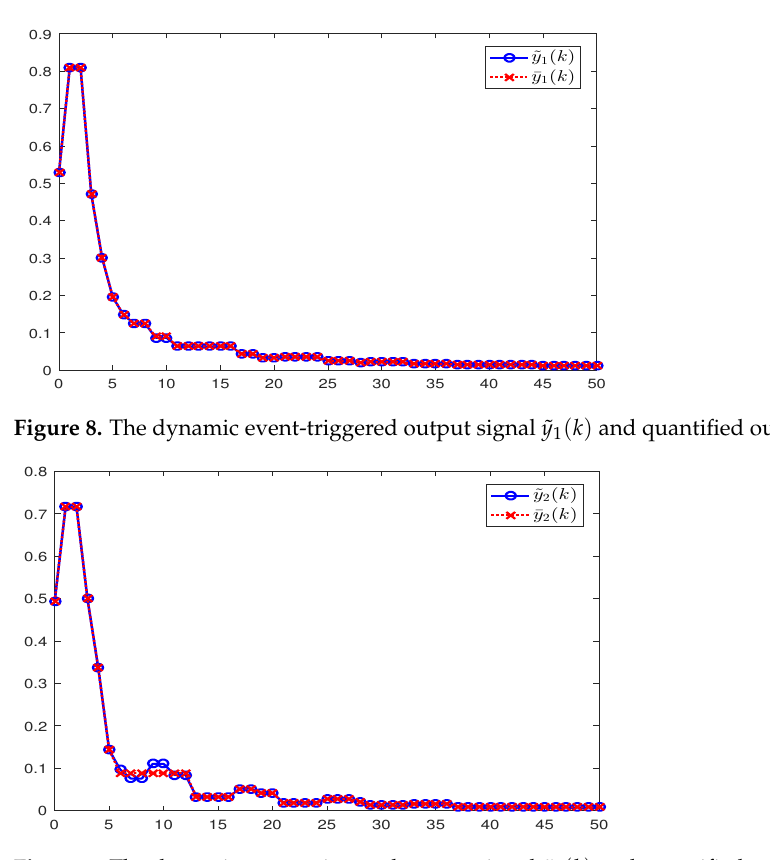
Figure 9. The dynamic event-triggered output signal ˜ y 2 ( k ) and quantified output signal ¯ y 2 ( k )